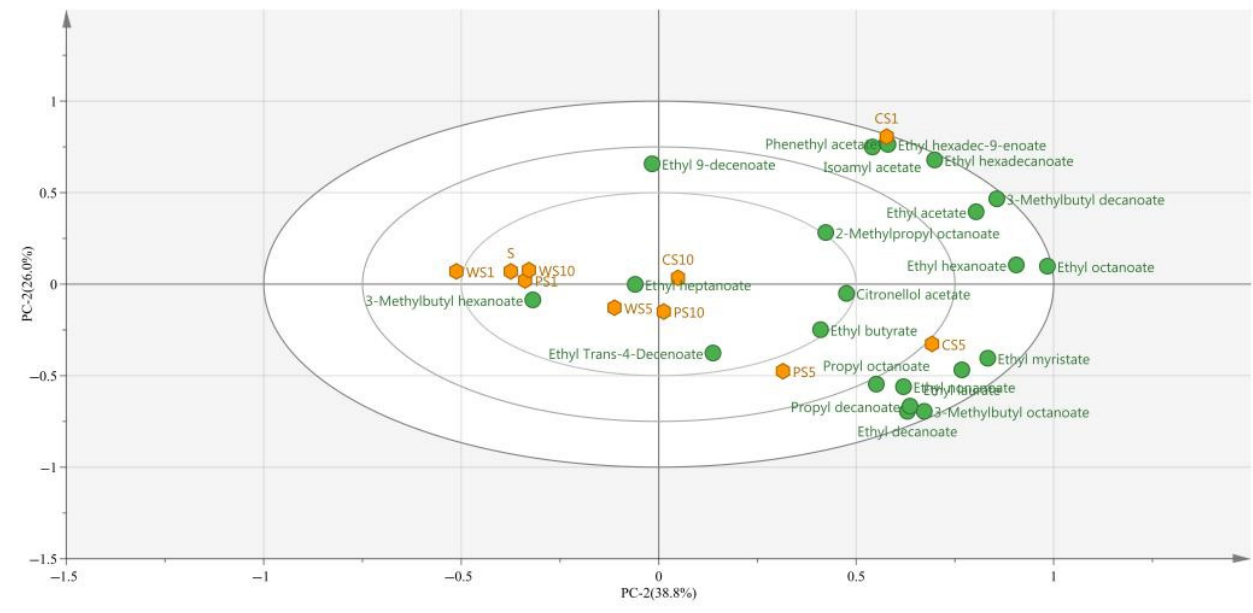
Figure 6. PCA of ester compounds during the simulated fermentation of blueberry